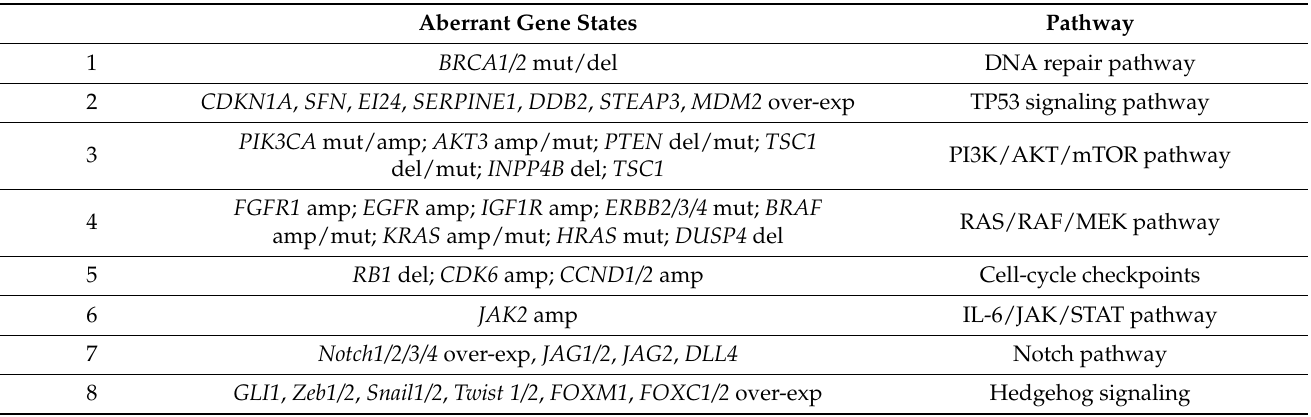
Table 1. Cell-signaling pathways in